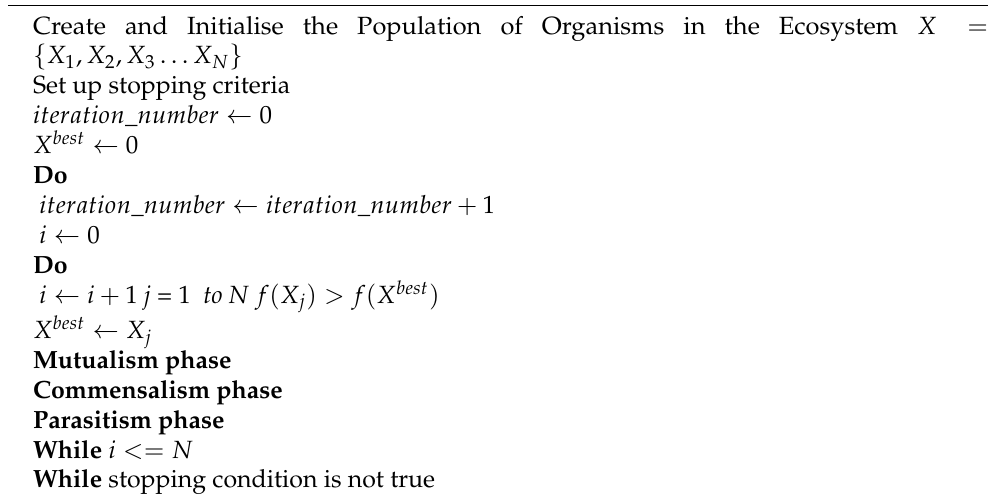
Algorithm 1 Standard Symbiotic Organism Search